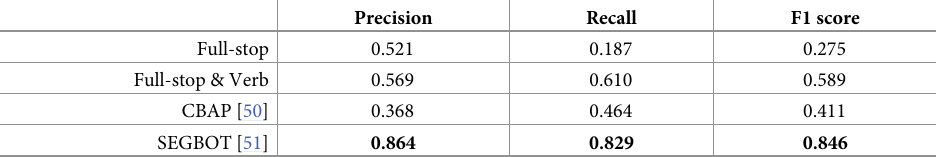
Table 5. Results of the segmentation task.